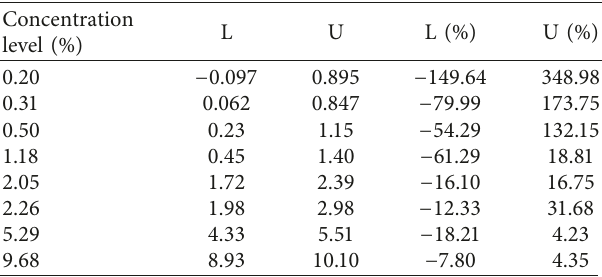
Figure 4: Accuracy profile for NIR quantitative methods. (a) Quantification of cryptotanshinone content; (b) quantification of tanshinoneII content. The medium blue dashed lines are the 66.7% β -content, 90% c -confidence tolerance intervals and the red lines are the acceptance limits ( 20%); the black point at each concentration level represents the relative bias for each predictive value. ± Table 5: The β -content, c -confidence tolerance intervals estimated for different concentration levels of cryptotanshinone .